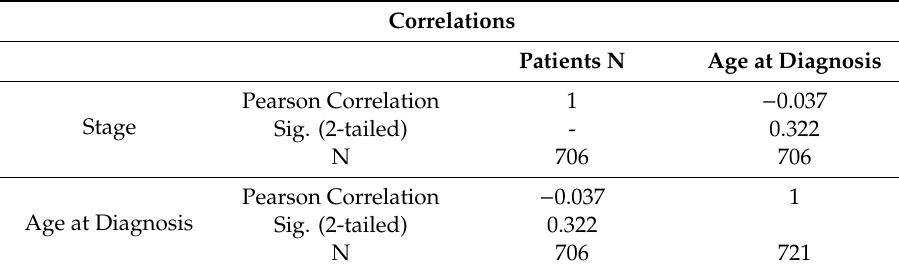
Table 5. Correlation between the stage of the disease and age at diagnosis.